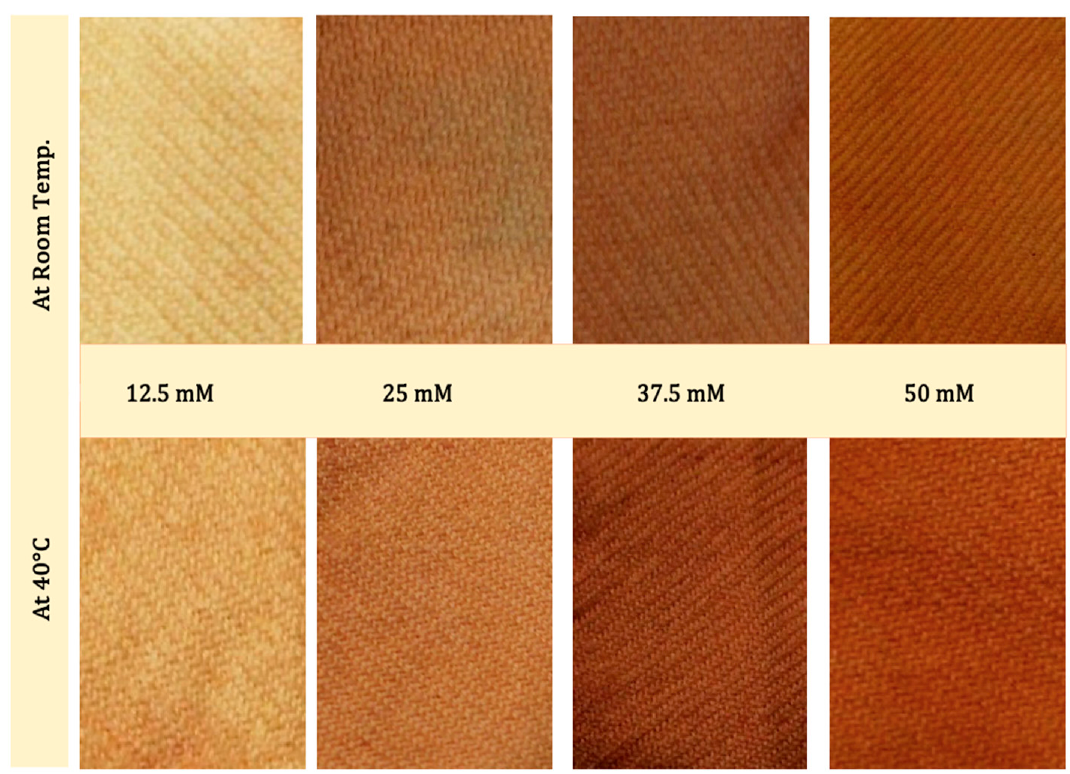
Figure 5. Photographs of Se-dyed wool fabrics with different concentrations of synthesized Se-NPs at room temperature and 40 °C.